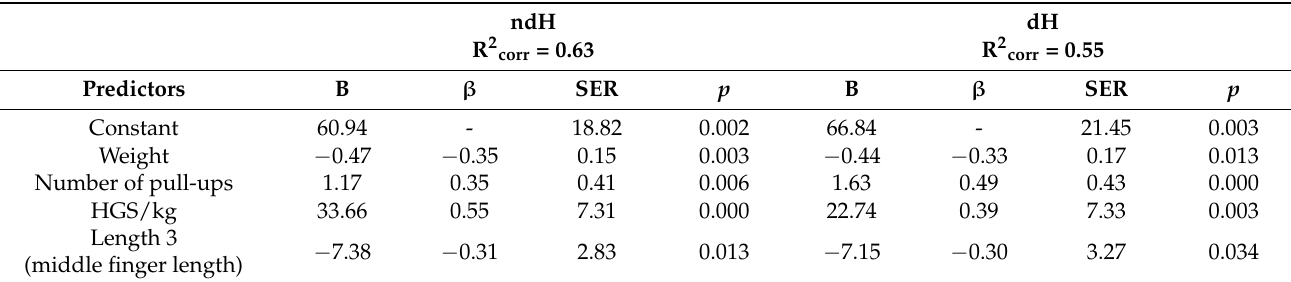
Table 2. Regressors of the multivariate model to predict the maximal climbing-specific holding time (CSHT) for dominant (dH) and non-dominant (ndH) hands. In addition, the regression coefficients, B; standardized coefficients, β ; standard error, SER (quality of the estimate); and p -values of the respective predictors are shown. HGS = hand grip strength.